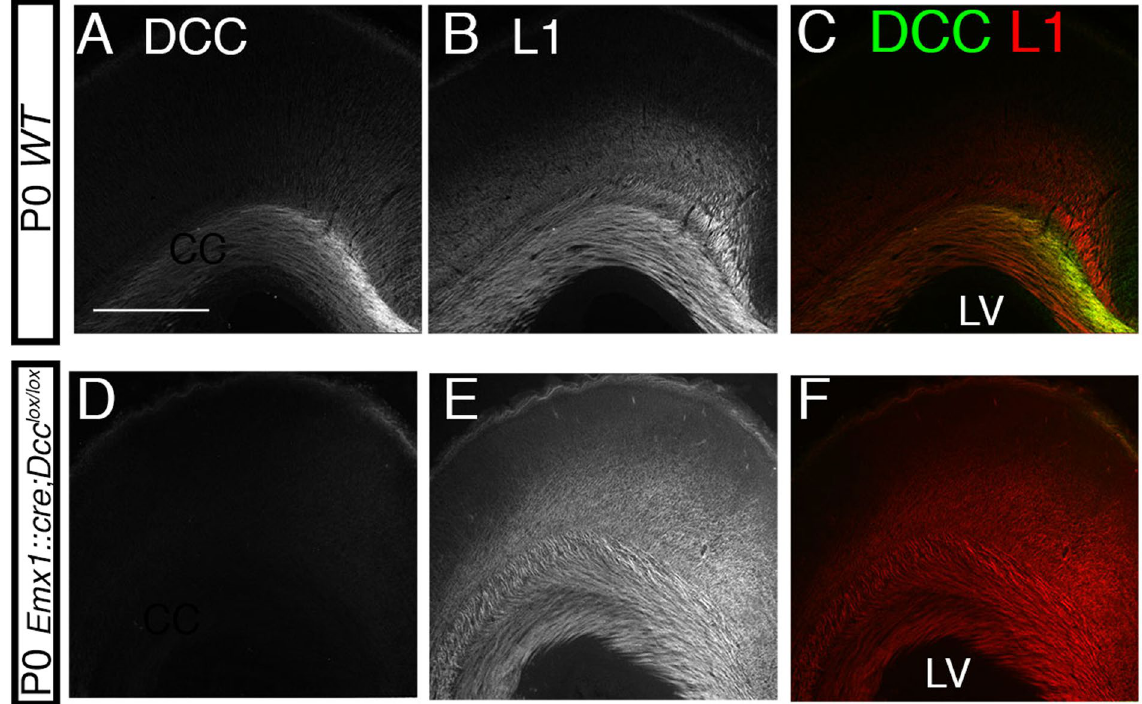
Figure 5. DCC is expressed in the neocortex and CC of wild type mice but not in Emx1 :: cre ; Dcc lox / lox mice. Coronal sections of P0 wild type mice (n = 3; A–C ) and of P0 Emx1 :: cre ; Dcc lox / lox mice (n = 3; D–F ) stained with anti-DCC and anti-L1. At P0, DCC was detected in the neocortex and CC of wild type mice ( A–C ). However, it was not detected in the neocortex of Emx1 :: cre ; Dcc lox / lox mice ( D–F ). The scale bar represents 168 μ m in A – F. LV: lateral